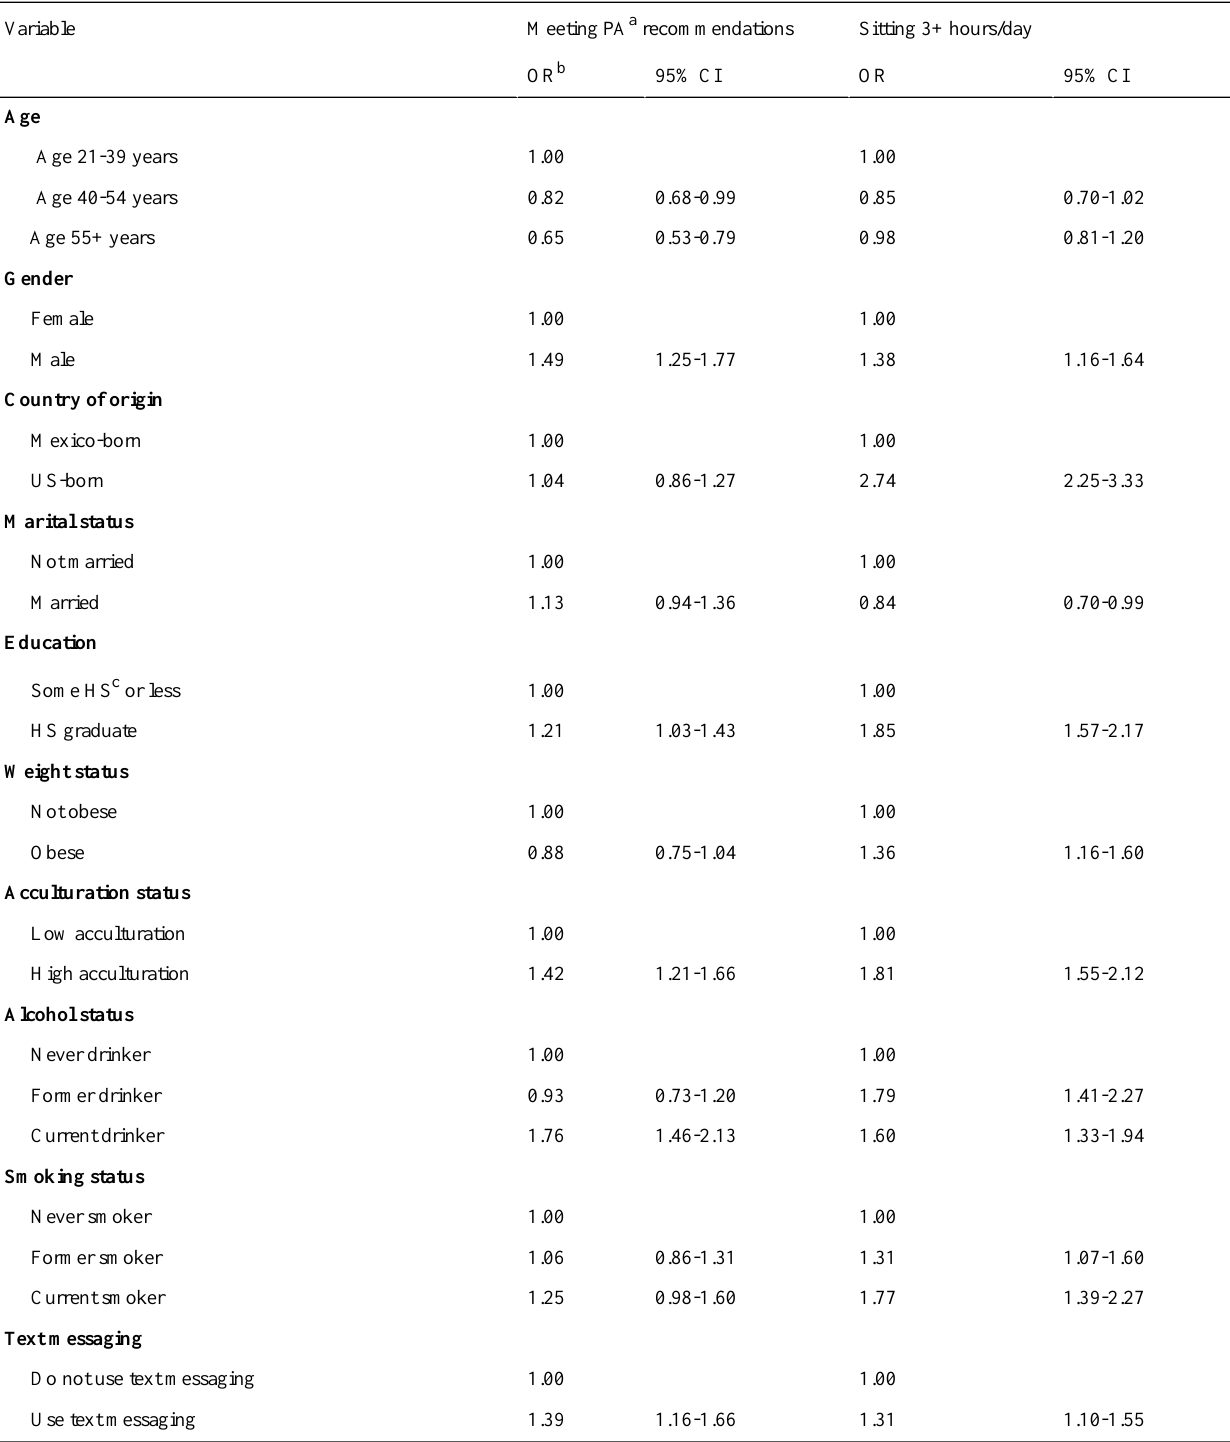
Table 2. Unadjusted odds ratios (95% CI) for mobile phone users for meeting physical activity recommendations and sitting 3 or more hours per day